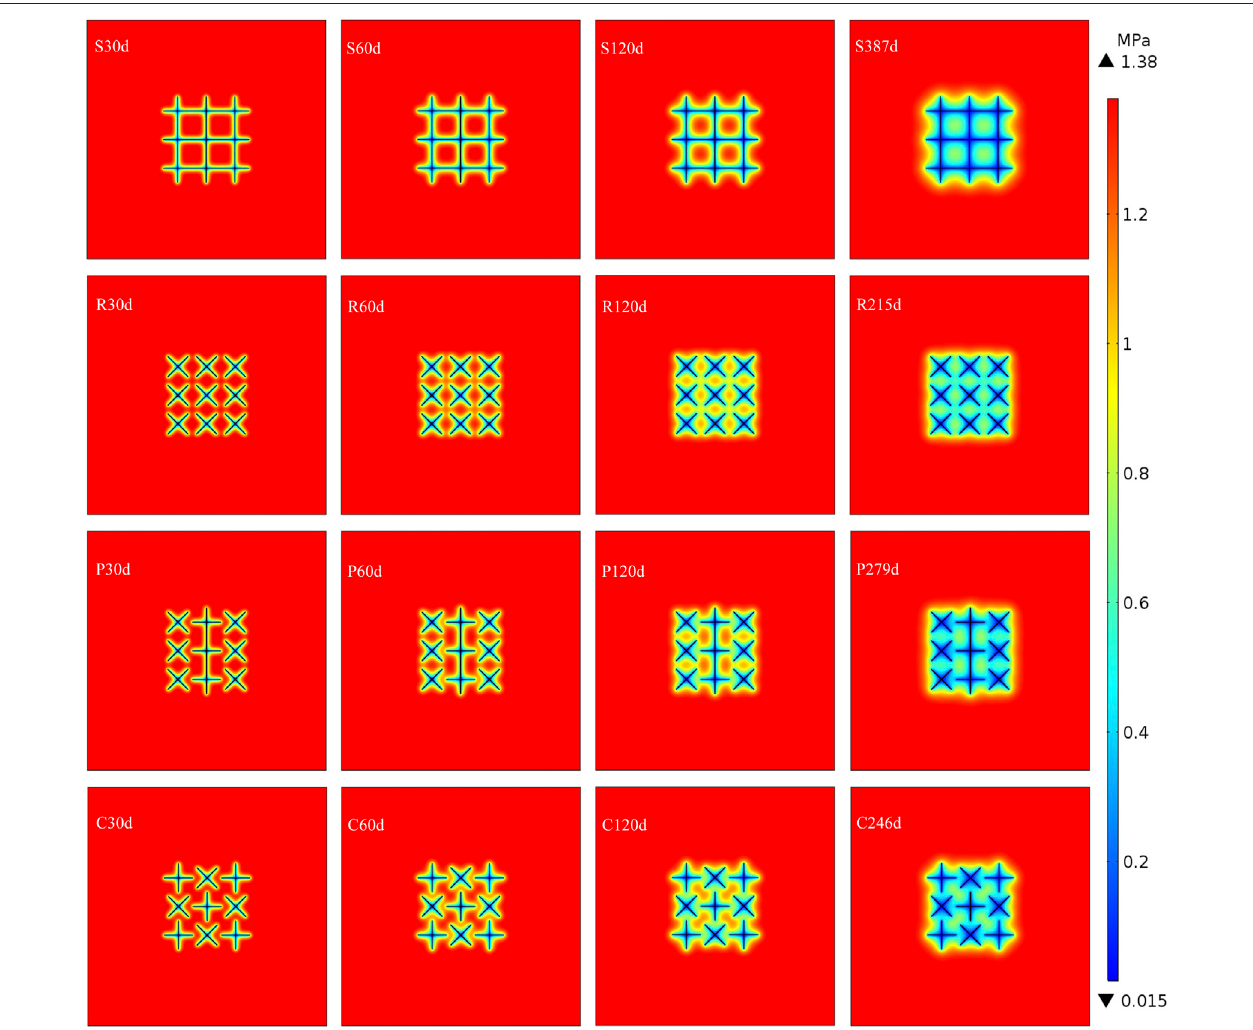
Frontiers in Energy Research |